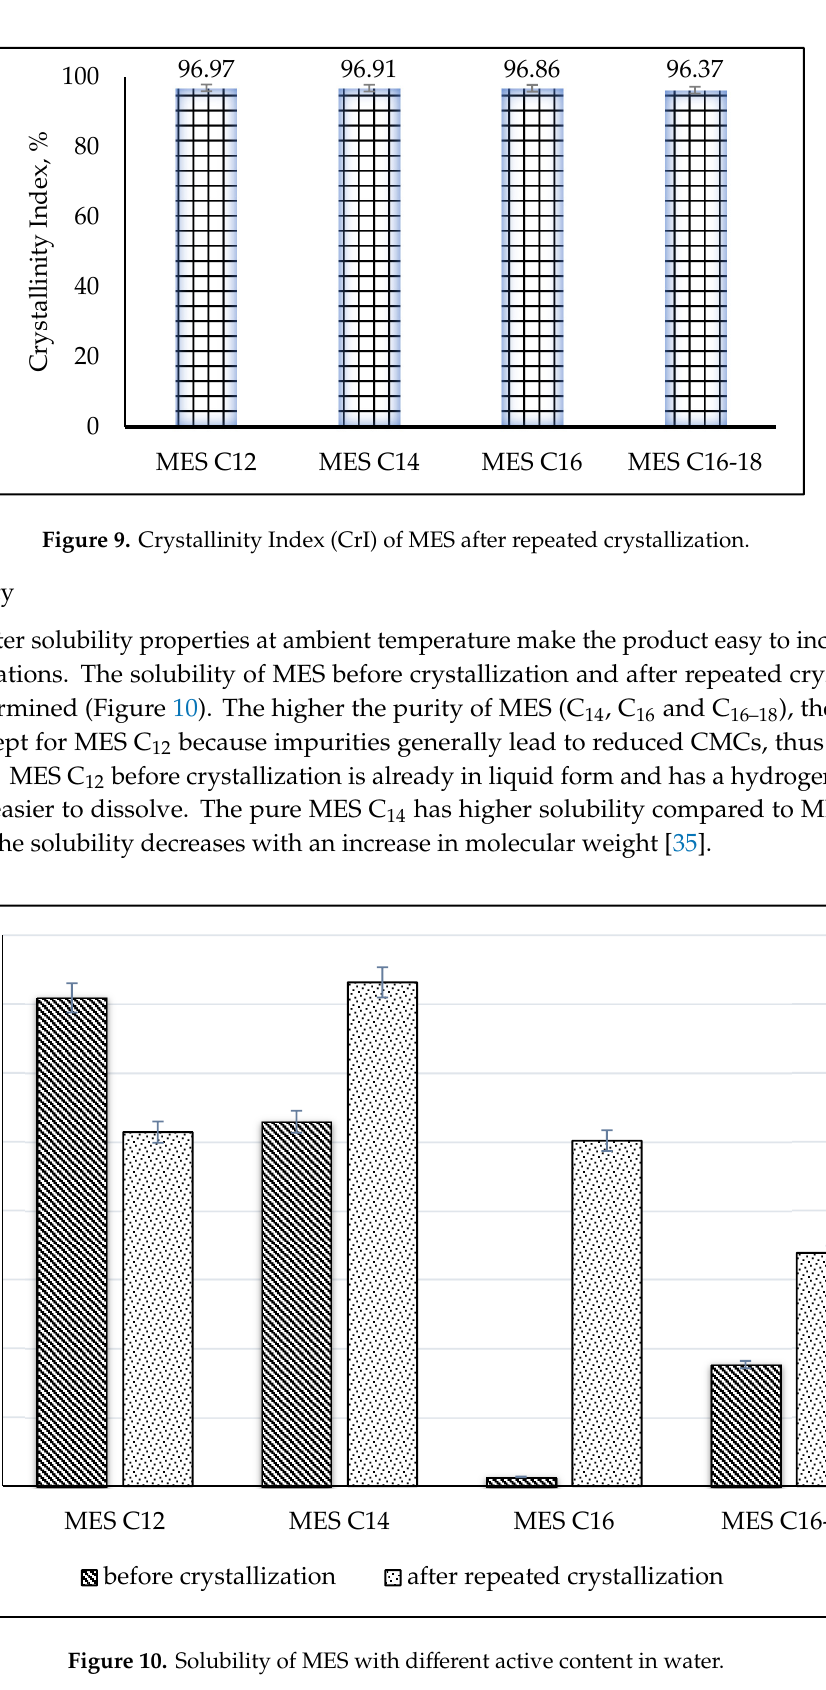
Table 6. Melting point of MES. Parameter